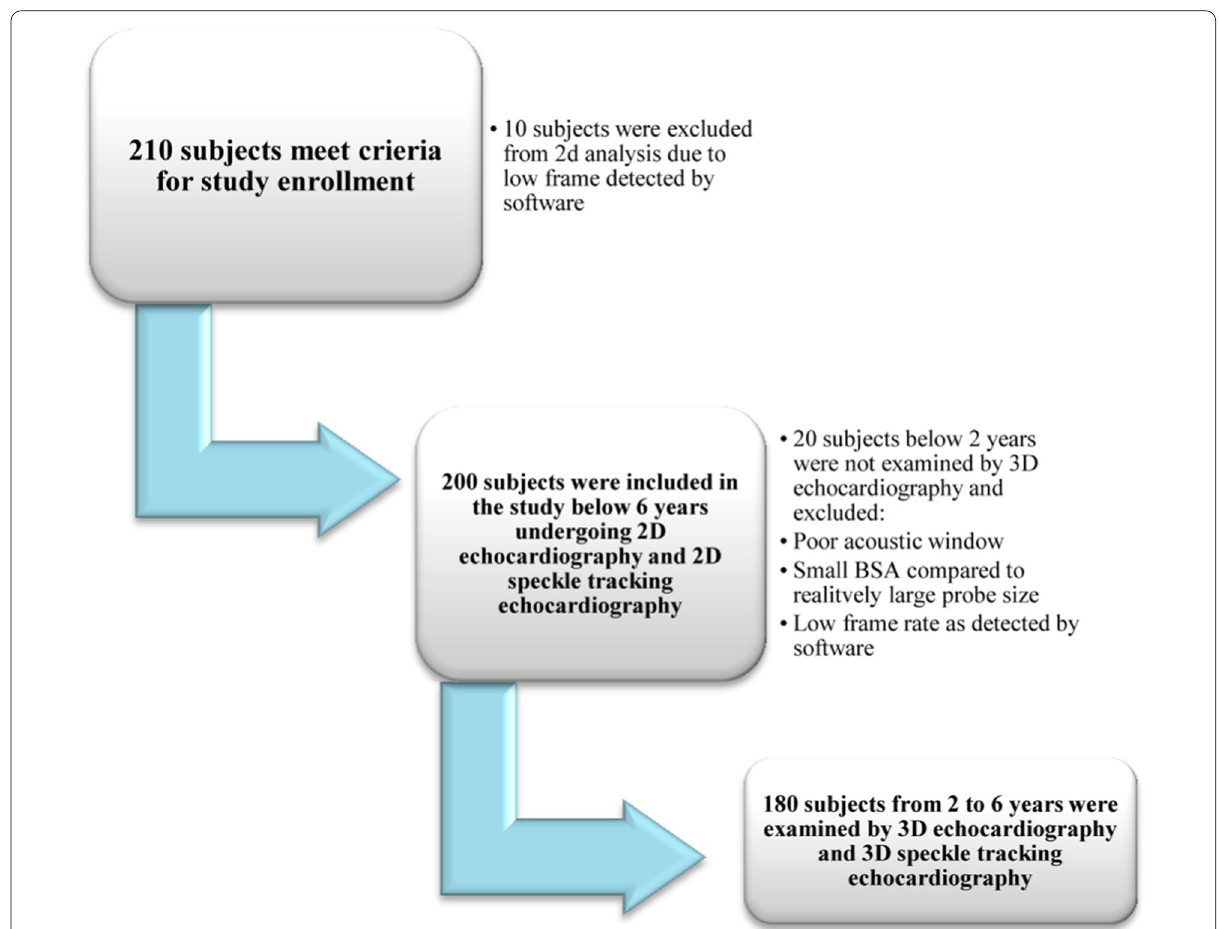
Fig. 2 Diagram of subjects examined by two-dimensional (2D) and three-dimensional